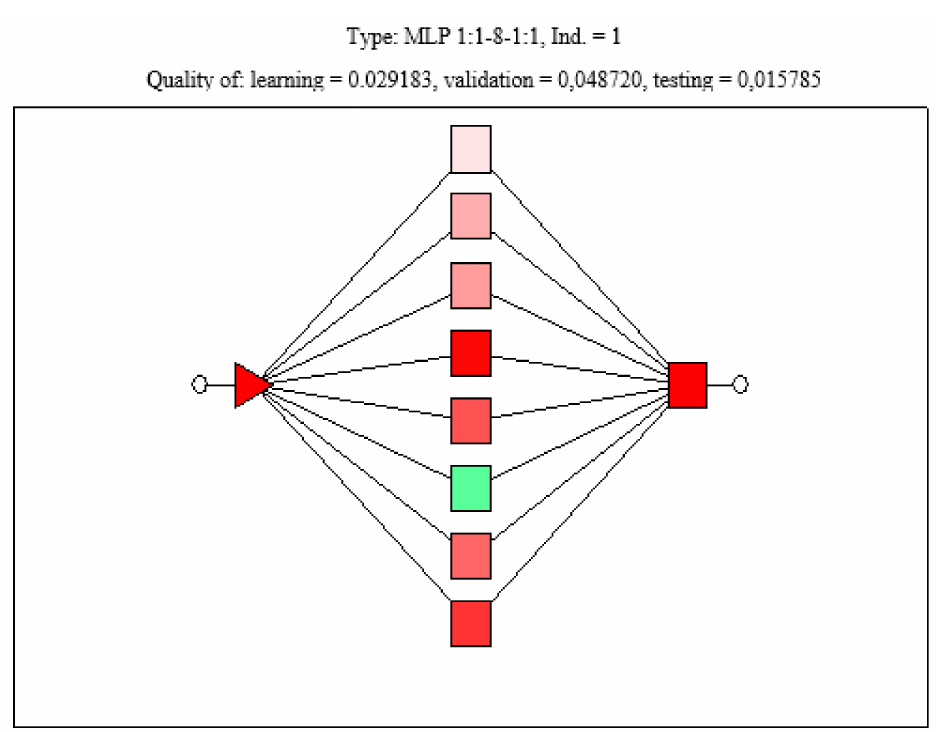
Figure 8. Architecture of MLP neural network model [own